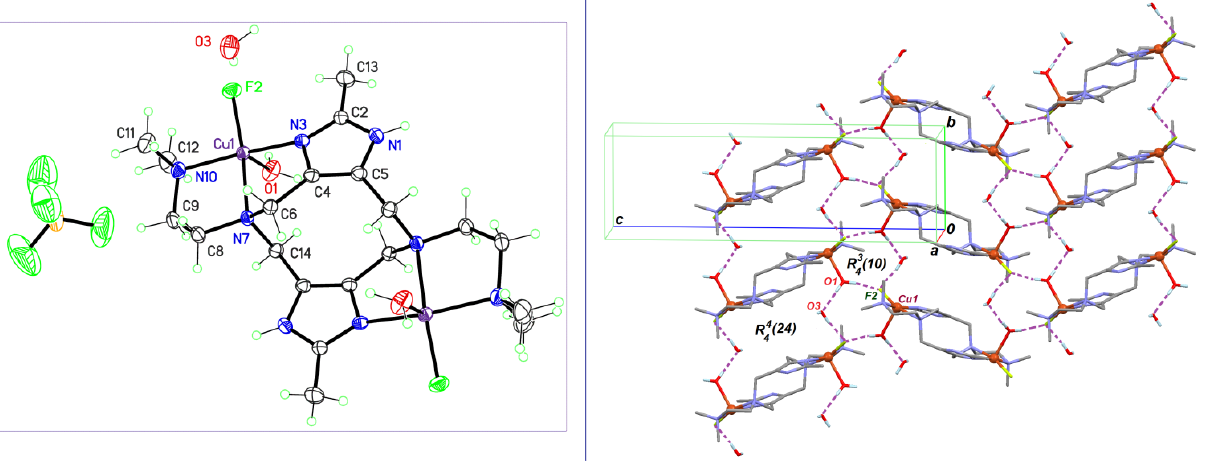
Figure 3. Left: One cation, one anion, and one lattice water molecule in the crystal of 2 . Right: Part of the crystal structure of 2 , showing the main R ring motifs. BF well as C– and N– bonded H atoms have been omitted for clarity. Dashed lines